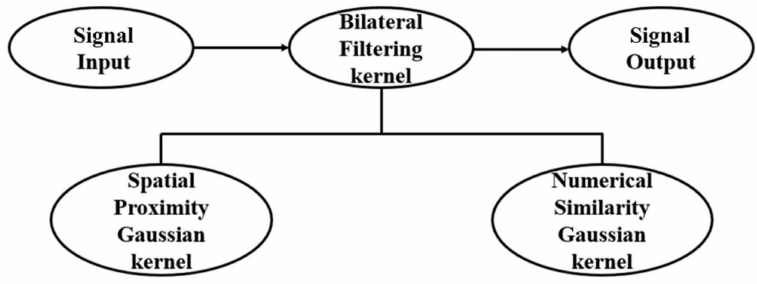
Figure 1. Schematic of a bilateral filtering